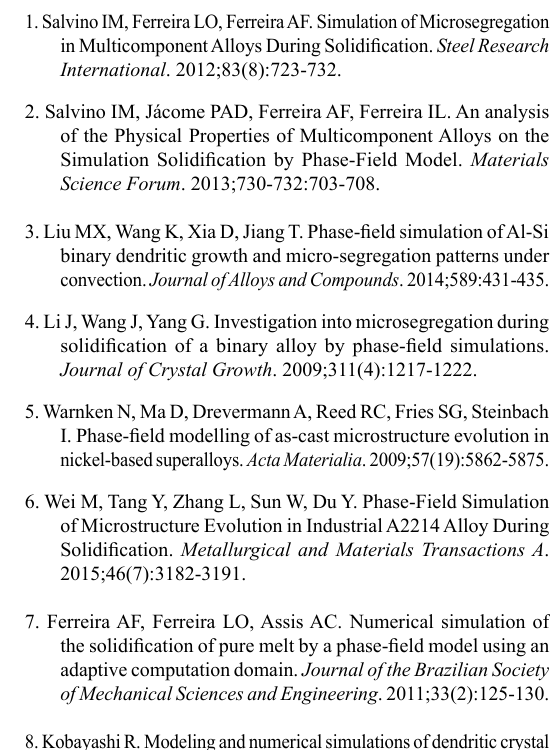
/C ) versus solidification max 0